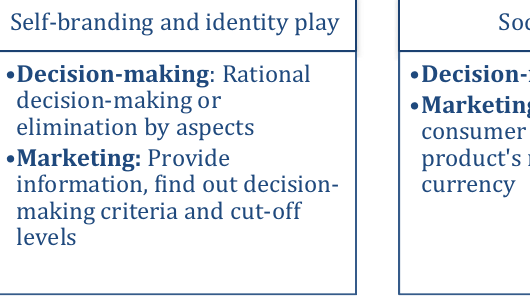
How decision-making and ideal marketing strategy vary according to the potential social role the product has Self-branding and identity play • Decision-making : Rational decision-making